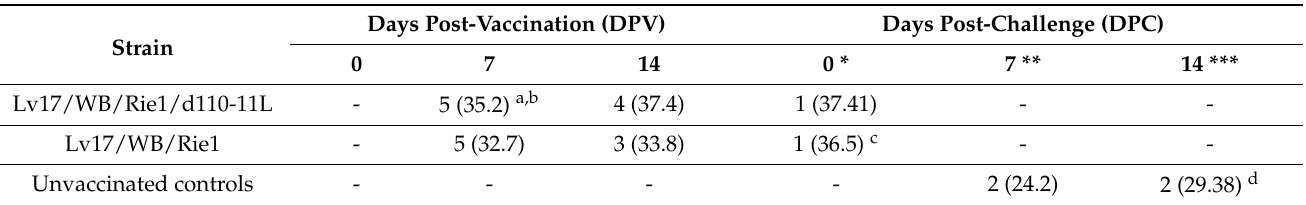
Table 8. Results of ASFV detection in pigs immunized with different African swine fever virus (ASFV) strains and challenged with Armenia/07 of ASFV by real-time PCR ◦